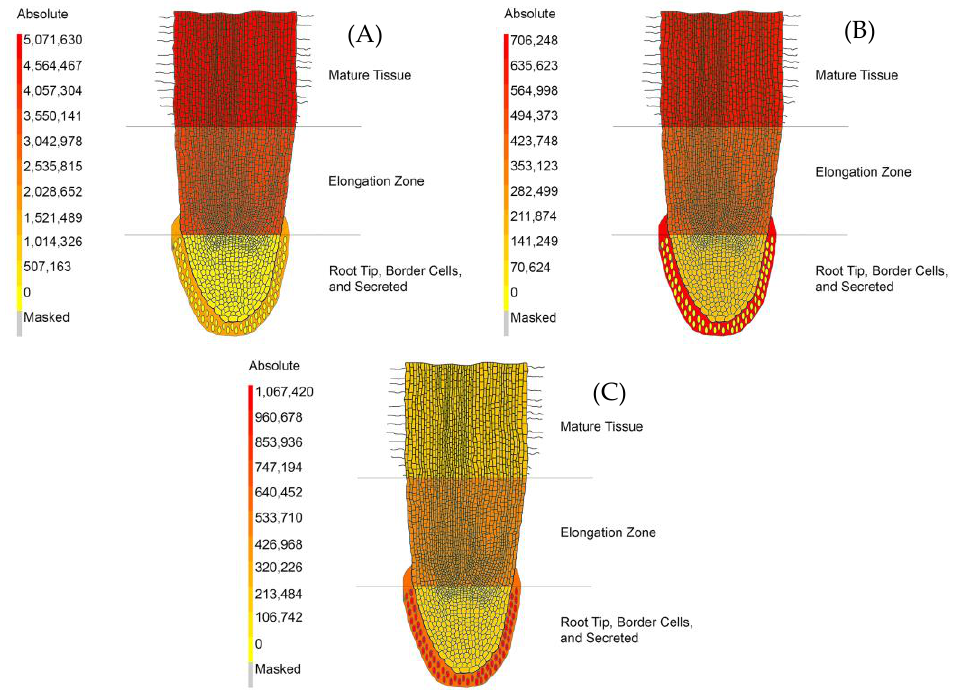
Figure 4. The Medicago truncatula Metabolite Atlas Spatial Localization of UHPLC–MS Analyzed Metabolites. ( A ) Relative spatial localization of phenylalanine. ( B ) Relative spatial localization of tryptophan. ( C ) Relative spatial localization of 7,4′-dihydroxyflavone. These data indicate variances in spatial localization of certain metabolites while showing them in a format that can be widely and easily understood.